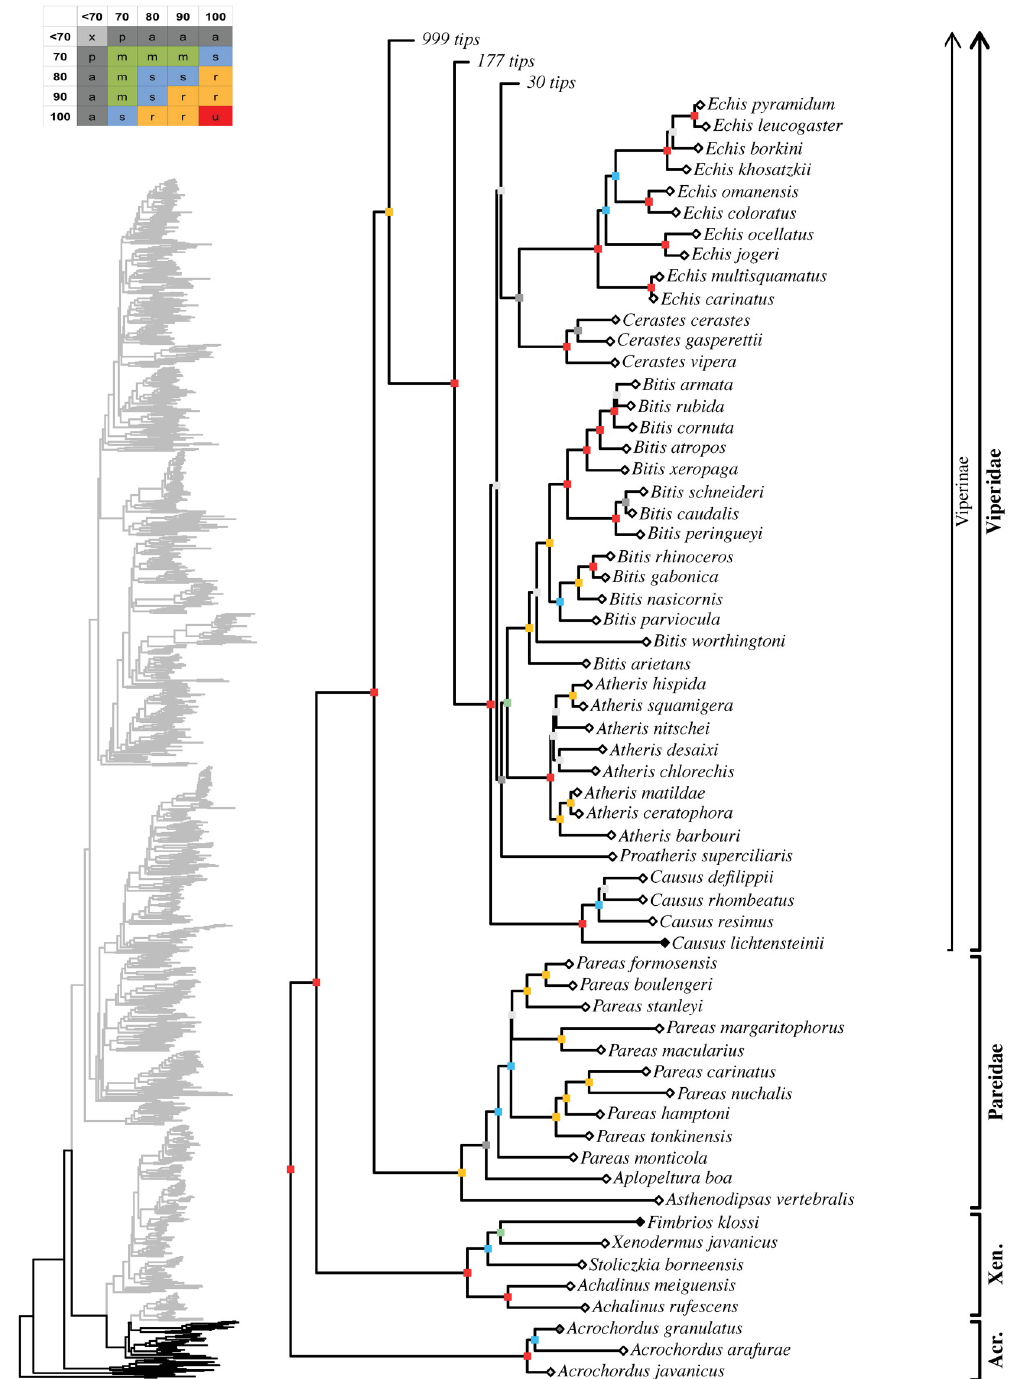
Fig 6. Maximum likelihood species-level phylogeny of Colubroides. Families Xenodermidae, Pareidae, subfamily Viperinae. Skeleton of the complete tree is displayed on the left, with the area of the tree corresponding to the present figure highlighted in black. Colored squares on each node represent bootstrap and SHL values following the categories of combined clade support described in S2 Table and summarized on the upper left corner of the figure. Diamonds on each tip represent the percentage of data generated in this study for each terminal: white, 0%; light grey, between 1% and 50%; dark grey, between 50% and 99%; black, 100%.